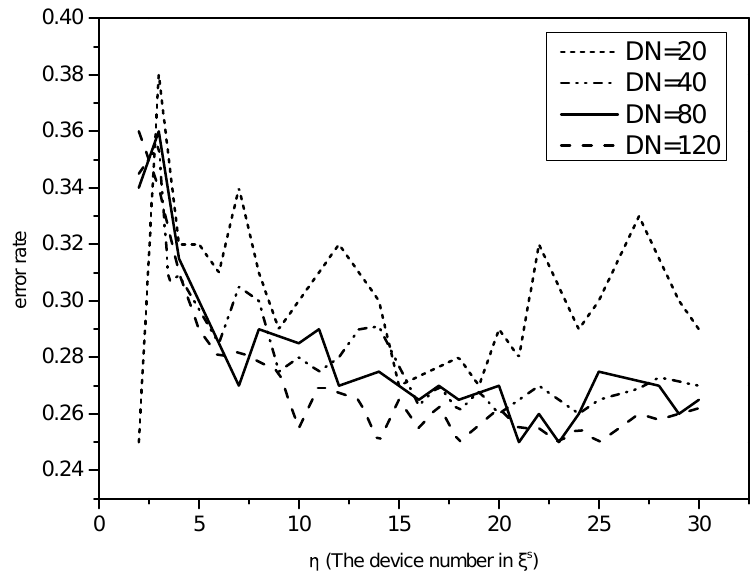
Figure 5. The error rate of the fusion-driven model based on Dempster–Shafer (D-S) evidence theory with different training set